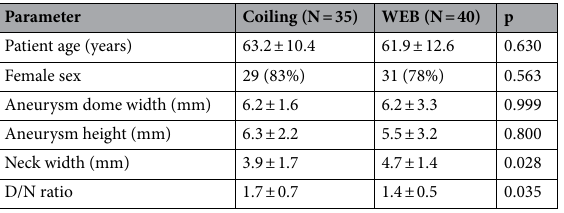
EZ and Atlas (Stryker, Alamazoo, MI, USA), Solitaire AB (Covidien, Irvine, CA, USA), eCLIPs (endovascular CLIP System, Evasc, Medical Systems Corp., Vancouver, BC, Canada), LVIS (Micronvention/Terumo, Aliso Viejo, CA, USA), Barrel stent (Barrel Vascular Remodeling Device (VRD) system; Medtronic, Minneapolis, Minnesota, USA), Acclino stent (Acandis, Pforzheim, Germany), LEO Baby (Balt, Duesseldorf, Germany) and Enterprise (Cordis Neurovascular, Miami, FL, USA). Anti-aggregation therapy.